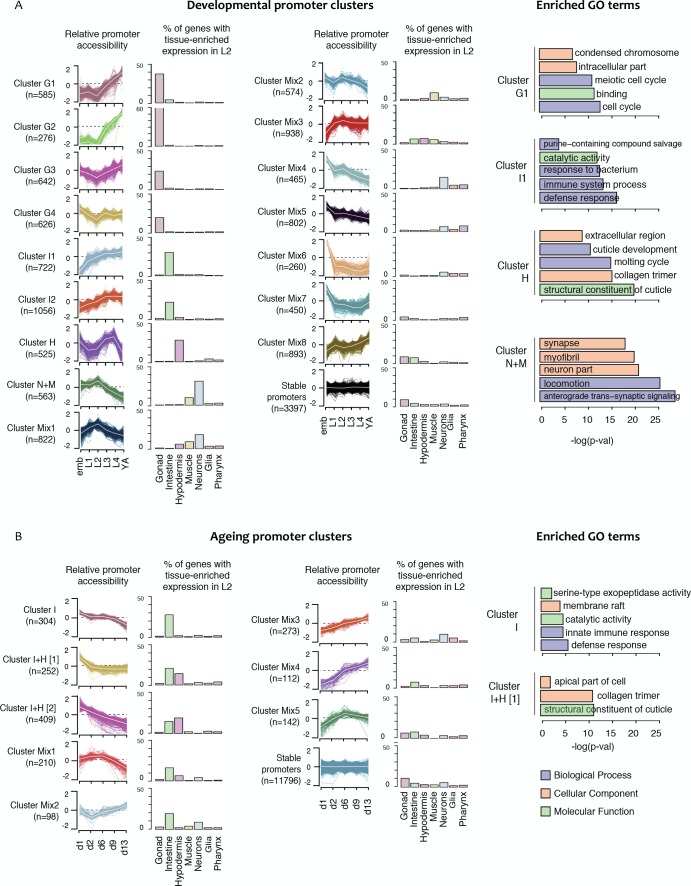
Shared dynamics of promoter accessibility in development and ageing.Clusters of promoters with shared relative accessibility patterns across (A) development or (B) ageing. Relative promoter accessibility is log2 of the depth-normalized ATAC-seq coverage at a given time point divided by the mean ATAC-seq coverage across the time series (see Materials and methods). The percentage of associated genes that have enriched expression in the indicated tissues was determined from single-cell L2 larval RNA-seq data (Cao et al., 2017); see Materials and methods). Right hand panels show examples of GO terms enriched in genes associated with development or ageing clusters.10.7554/eLife.37344.021Figure 4—source data 1.Element accessibility dynamics and promoter accessibility clusters in development and ageing.● chrom_ce10, start_ce10, end_ce10 location of the accessible site (bed-style coordinates, ce10). ● devel_is_dynamic True or False based on whether the site shows differential accessibility between any two developmental stages. ● ageing_is_dynamic True or False based on whether the site shows differential accessibility between any two ageing time points. ● devel_prom_cluster_label assigned developmental accessibility promoter cluster. ● ageing_prom_cluster_label assigned ageing accessibility promoter cluster. ● HOTness based on the number of transcription factors overlapping the accessible site, either HOT (19 or more factors), cold (between 1 and 18 factors) or none (zero factors). ● factor_count number of transcription factors with binding sites overlapping the accessible site. ● factor_names comma-separated list of the names of transcription factors with binding sites overlapping the accessible site.